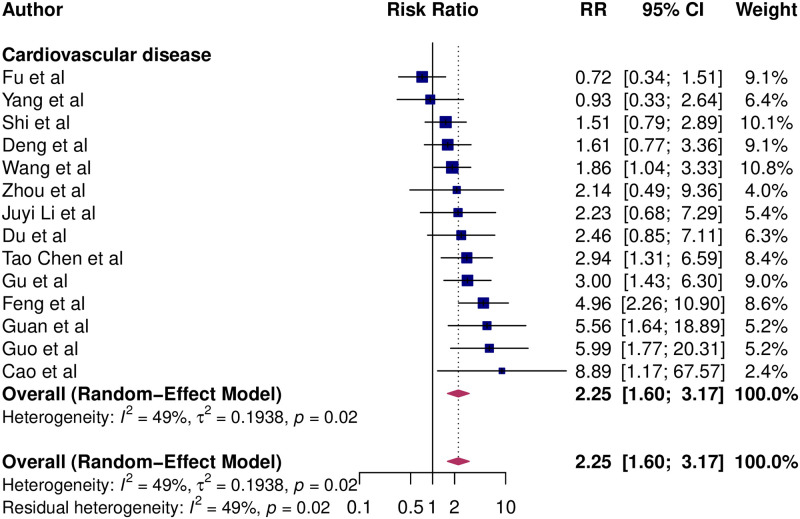
Association of cardiovascular disease and mortality risk from COVID-19.Blue squares and their corresponding lines are the point estimates and 95% confidence intervals per each study. Maroon diamond represents the pooled effect estimate.